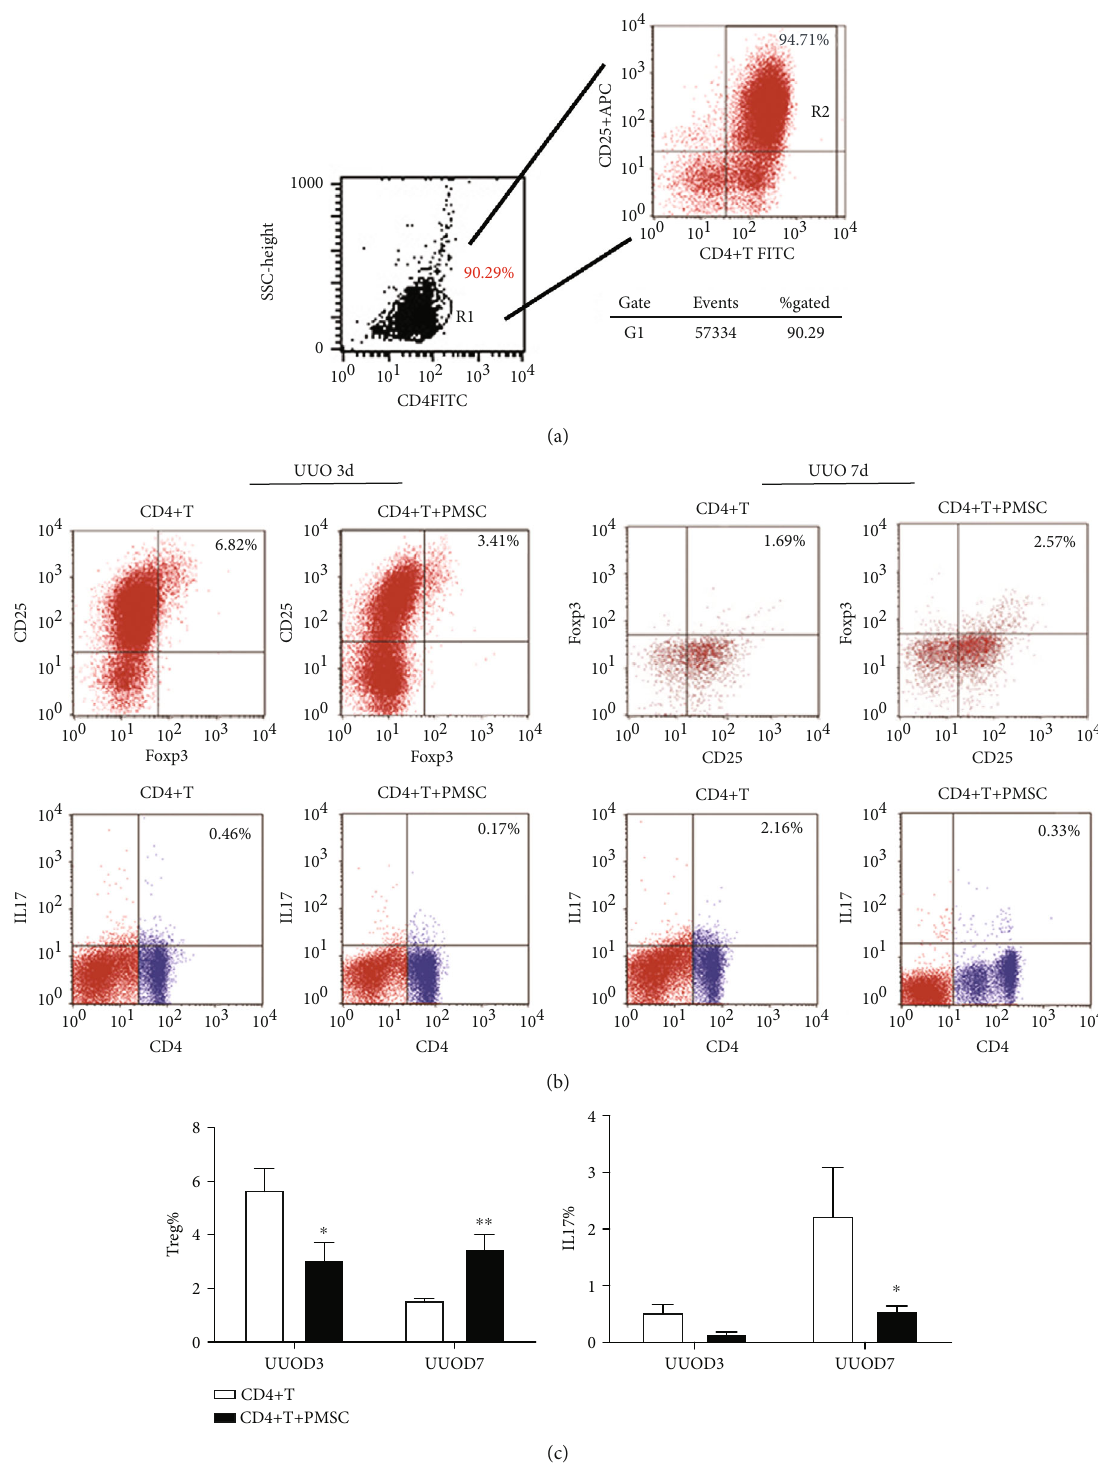
Figure 4: PMSCs treatment increase Treg and decrease Th17 expression in CD4 + T cells from PBMC in vitro. (a) CD4 + T cells were obtained from PBMC of rats at day 3 and 7 after UUO via microbeads, respectively, and cocultured with or without PBMCs. (b) A 0.4 μ m transwell system was used and activated CD4 + T cells were seeded in the lower chamber while PMSCs were seeded in the upper chamber. After 72 hours of incubation, CD4 + T cells were stained with CD25-APC and Foxp3-FITC or IL17-APC, CD4-PE, respectively. (c) Histograms representation of the percentage of Treg cells (CD25 + Foxp3 + ) and IL17 + CD4 + T cells in CD4 + T cells cocultured with or without PMSC. Error bars are ± SD. ∗ P < 0 : 05 compared with CD4 + T cells group; ∗∗ P < 0 : 01 compared with CD4 + T cells group. n = 4 in each